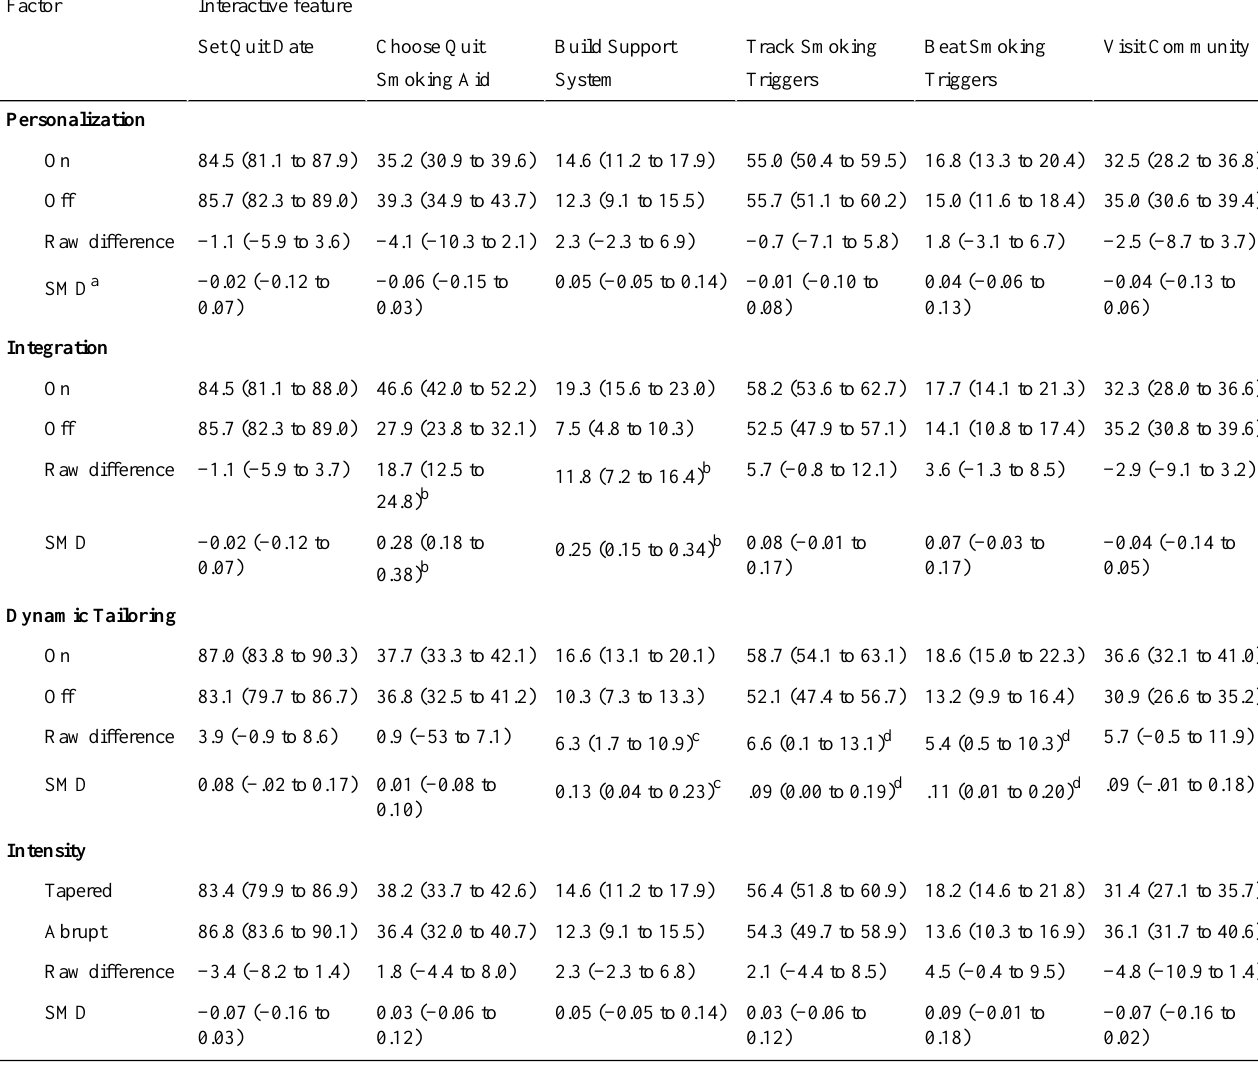
Table 1. Marginal effects of experimental design factors on interactive feature utilization rates (95%